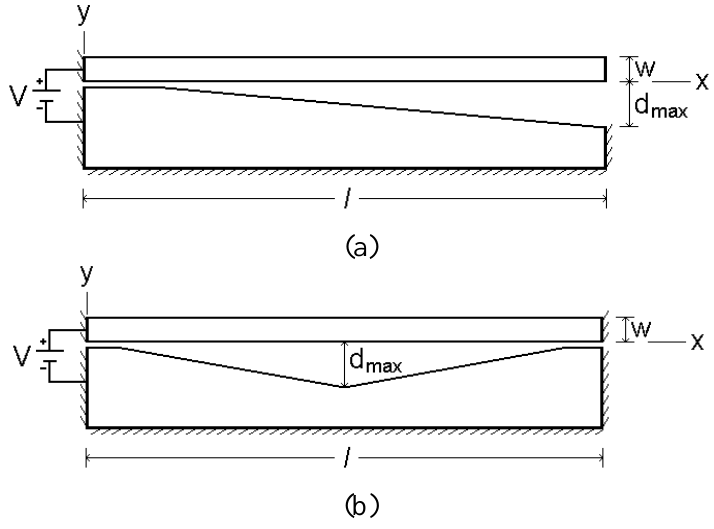
Figure 6. Linearly varying beam profiles (a) cantilever (b) fixed-fixed.